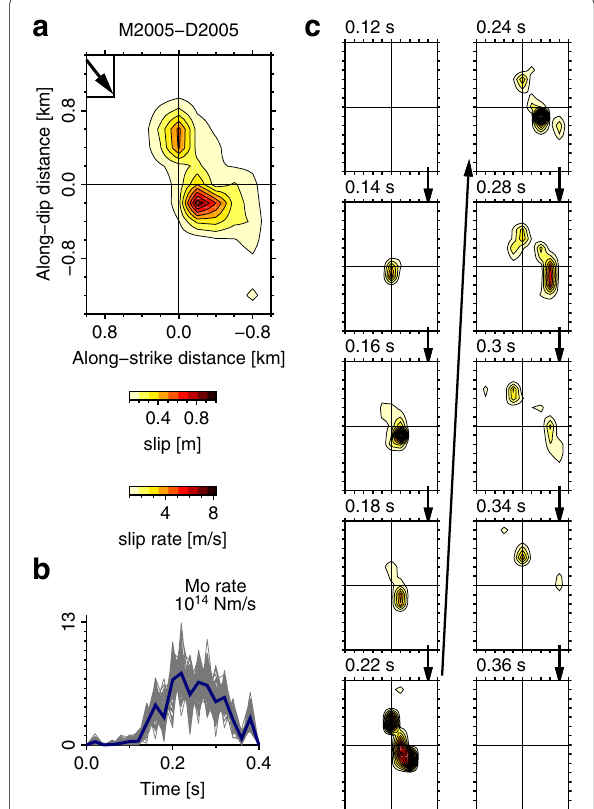
Fig. 5 M2005 source process. a Total slip distribution. The down direction in the figure indicates the down-dip direction,and the black arrow at upper left shows the slip direction from the F-net data.The origin indicates the D2005 source location (eGf event). b Moment rate function, with the gray lines representing each trial and the blue line being the average. c Slip rate history. The modeled region in ( c ) is the same as in ( a